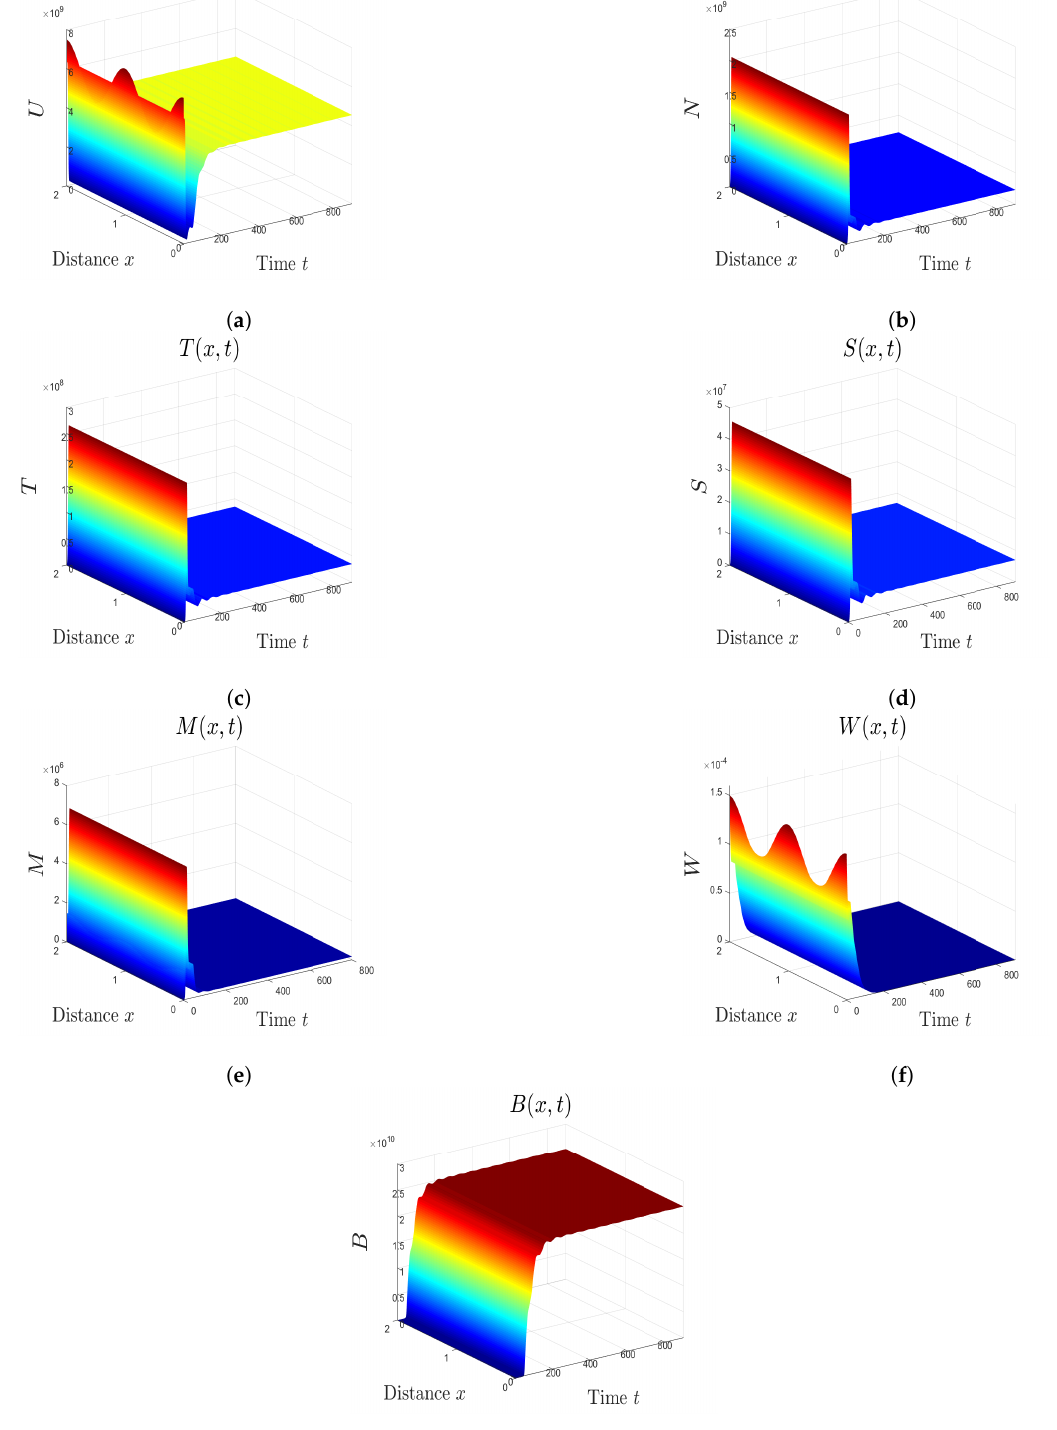
Figure 3. The numerical simulations of model (3) when R j > 1 and R l ≤ 1. The antibody-activated equilibrium E 2 is globally asymptotically stable. The subfigures show the spatiotemporal behaviors of ( a ) uninfected red blood cells U , ( b ) ring infected red blood cells N , ( c ) trophozoite infected red blood cells T , ( d ) schizont infected red blood cells S , ( e ) free merozoites M , ( f ) CTLs W , and ( g ) antibodies B